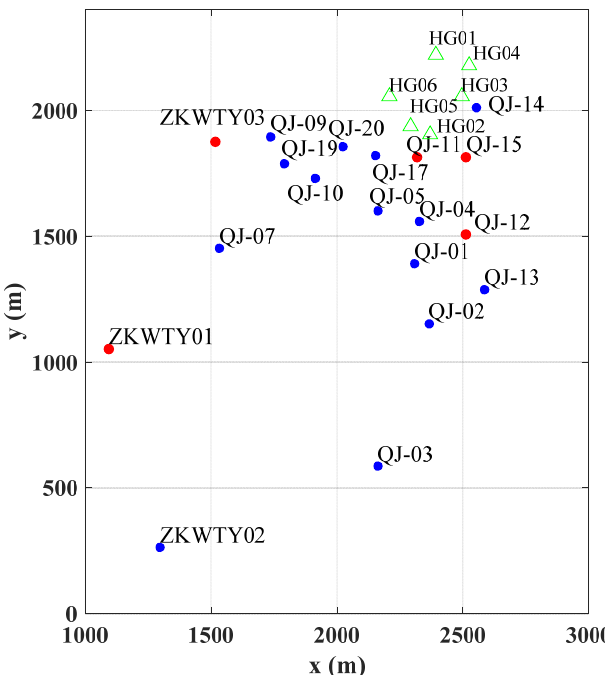
Figure 2. Wells locations in Cuona. The unit is meter. Blue dots are wells with temperature lower than 45 °C, red dots are wells with temperature higher than 45 °C and green hollow triangles are new drilled wells.